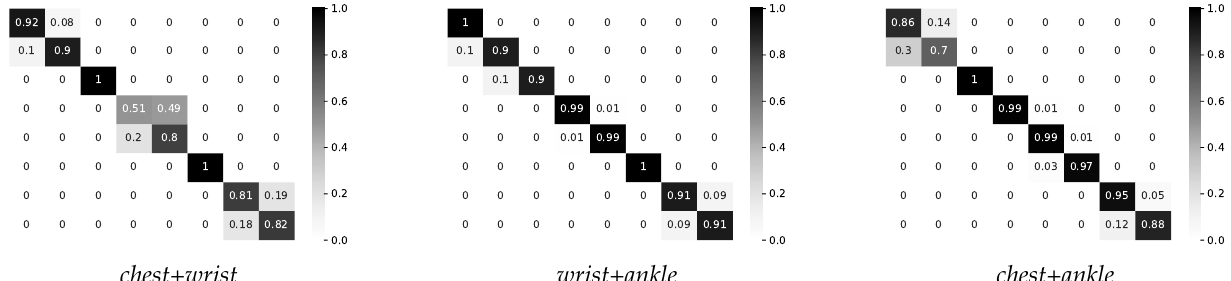
ankle sensors, an overall accuracy of 91.83% was obtained, recognizing all eight types of physical activity. Confusion matrices for all three modalities are present in Figure 9.